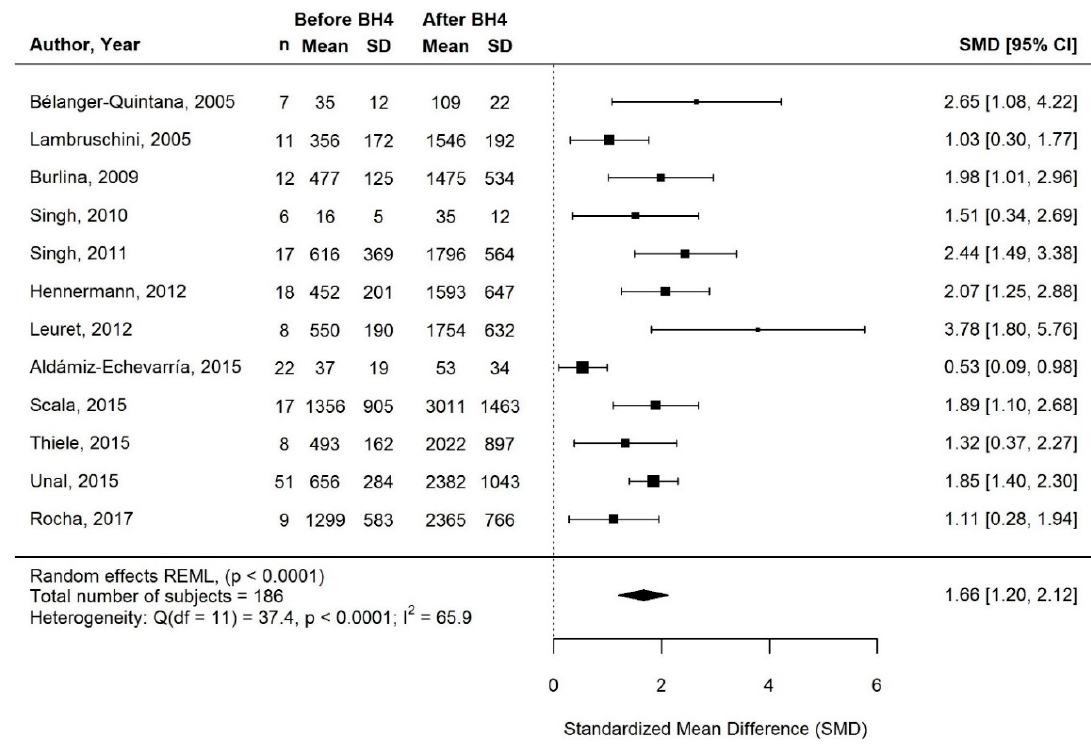
Figure 2. Standardized change in phenylalanine intake of long-term responders on BH4 treatment. Means and SDs before/after BH4 are milligram phenylalanine per kilogram bodyweight per day for Belanger-Quintana (2005), Singh (2010), and Aldámiz-Echevarría (2015), and milligram per day for all other studies. Abbreviations: BH4, tetrahydrobiopterin; CI: confidence interval; n: sample size; SD: standard deviation; SMD, standardized mean difference.